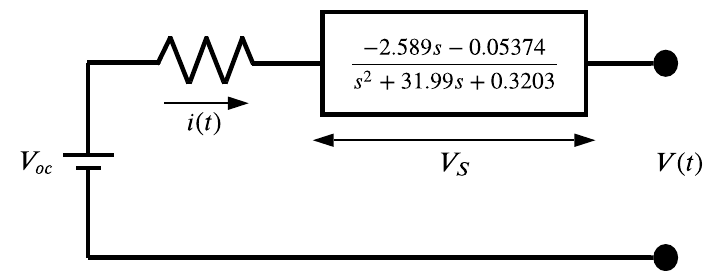
Figure 3. Battery model using modified Thevenin